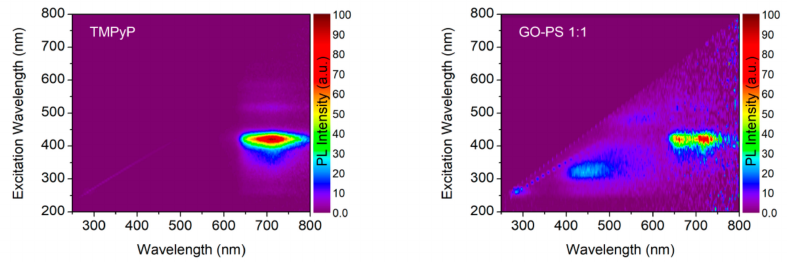
Figure 3. Normalized excitation–emission color maps of TMPyP ( left ) and GO / TMPyP (1:1) ( right ) samples.